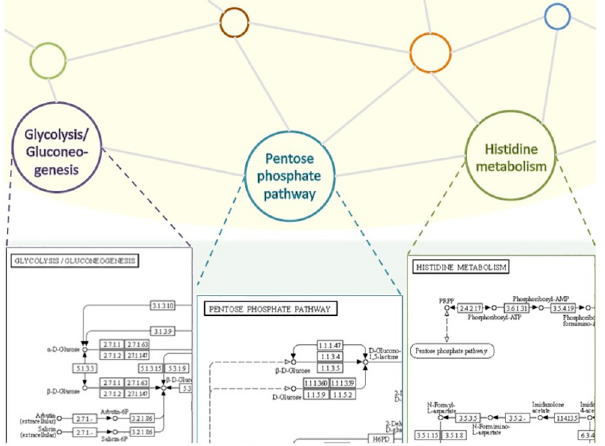
Fig 2. A two-level view of the metabolism: The Structural level (yellow background) and the Functional level (green background).